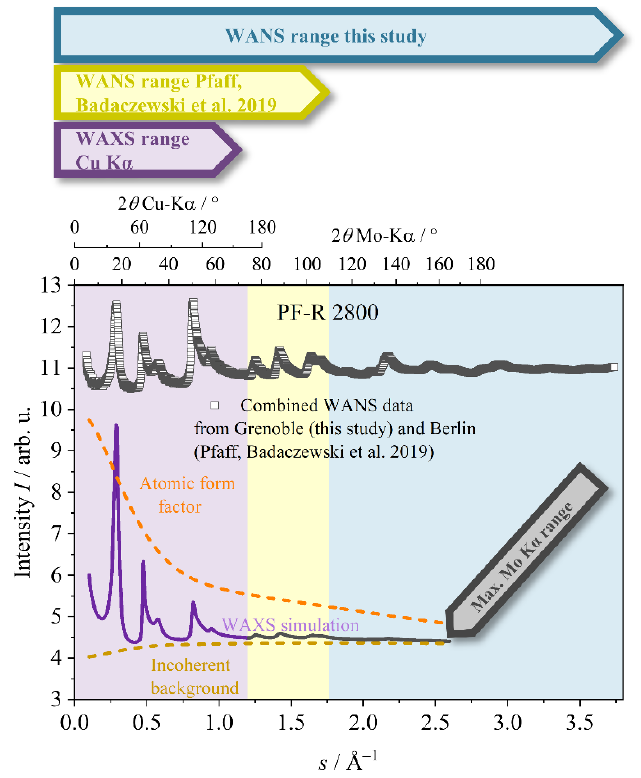
Figure 3. Illustration of the shortcomings of X-rays in the analysis of NGCs and the advantage of WANS. The merged WANS data shown (sample PF-R 2800, a phenol-formaldehyde resin) were obtained from a beamtime at Grenoble (this study) and from an HZB (Berlin) beamtime, see Pfaff et al. [43]. While WAXS data suffer from the damping induced by the atomic form factor, by using WANS data more distinguishable reflections can be obtained and analyzed. Also, WAXS measurements with, e.g., Mo-K α radiation, which makes high values of the s accessible too, may not significantly improve the evaluation, since the atomic form factor leads to a substantial damping in this case. Additionally, when using X-ray radiation, the incoherent background must be taken into account and calculated exactly for a quantitative analysis.